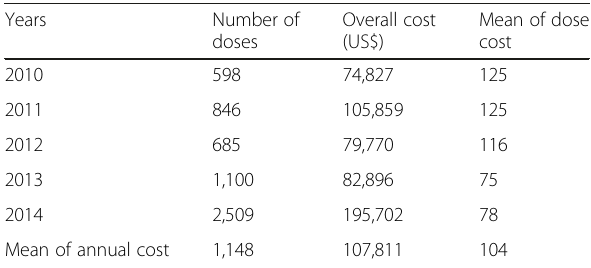
Table 3 Geographical annual incidence of snakebites